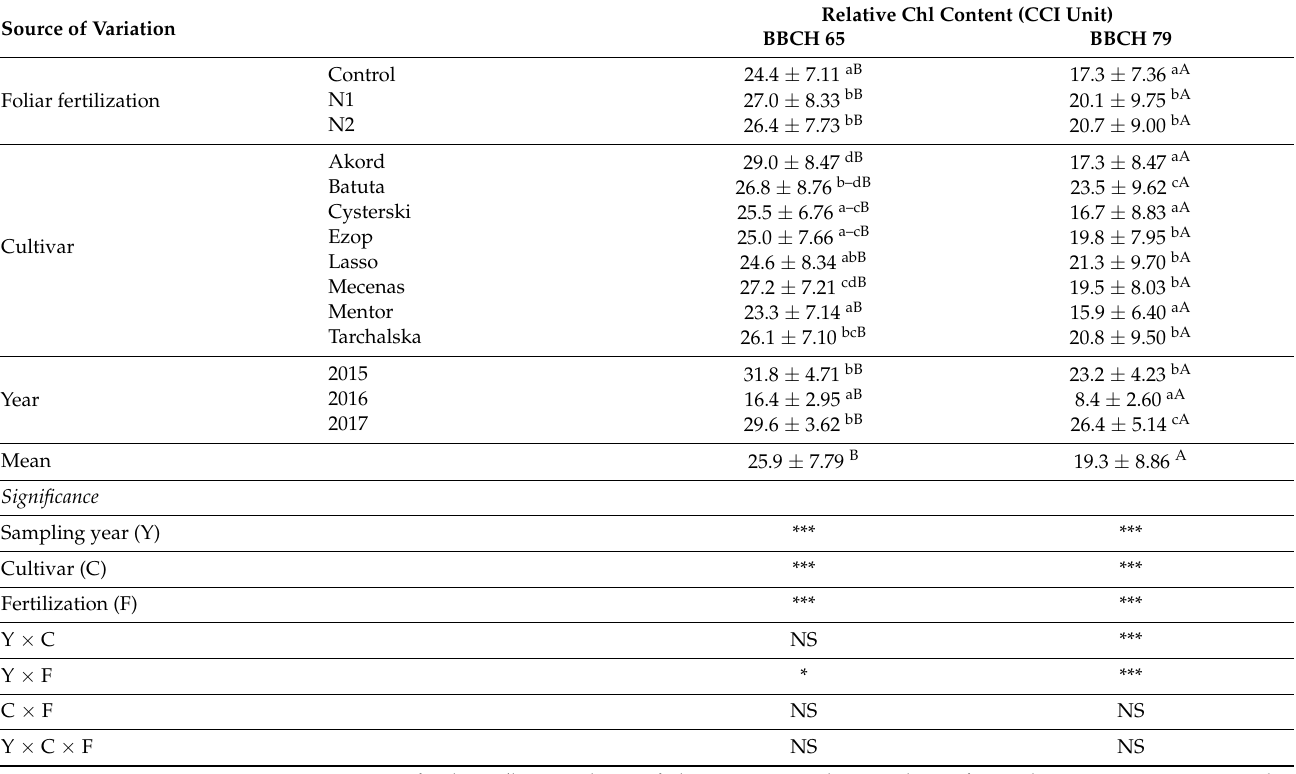
Table 1. The relative Chl content (CCI unit) in the pea bract at the two growth stages (BBCH 65 and BBCH 97) depending on fertilization (F; Control, N1, N2), cultivar (eight cultivars) and